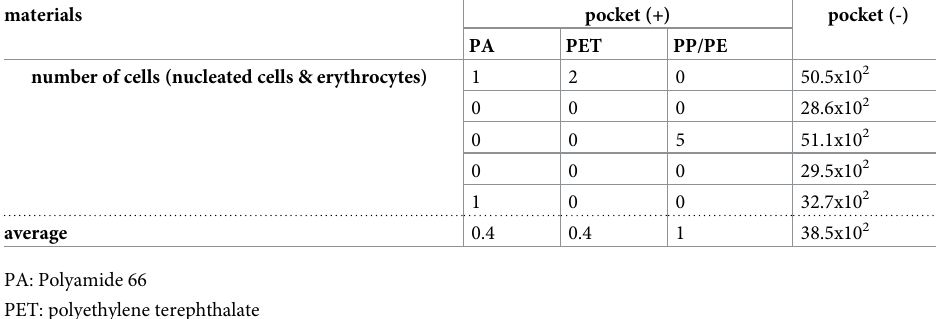
Table 5. Wrapping effects according to materials in FFPE tissue models. materials